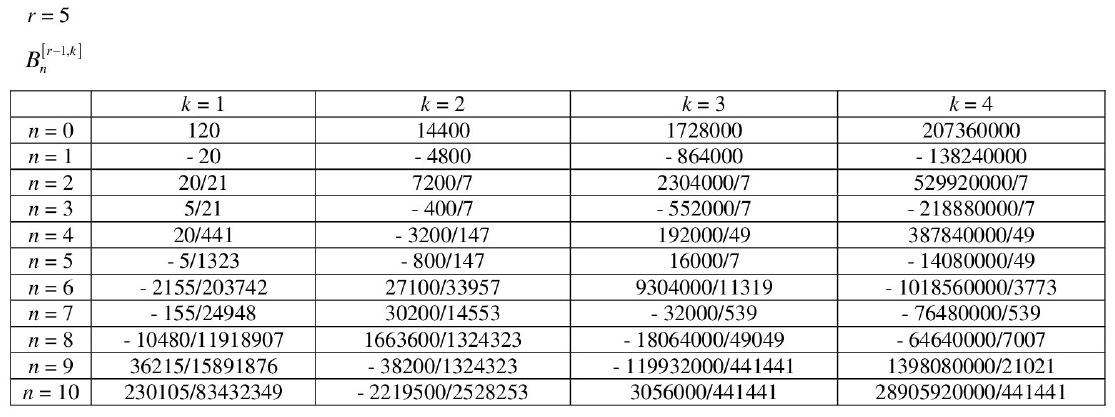
[ 4, k ] = 1,2,3,4; n = 0,1, . . . n ; k